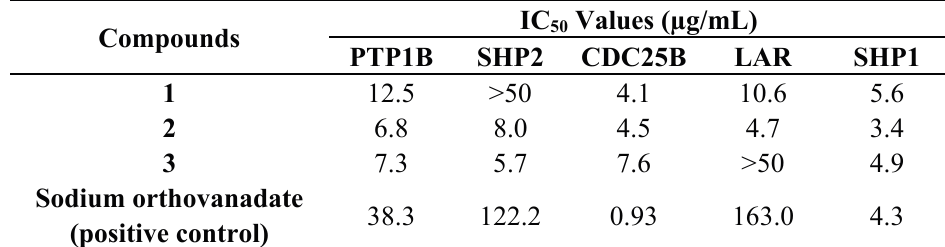
Table 4. The activity of enzyme inhibition of compounds 1 – 3 .